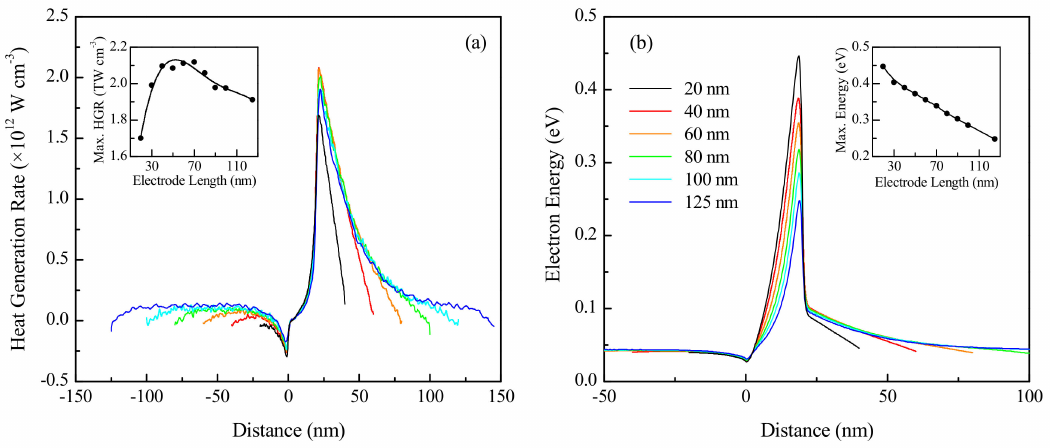
Figure 7. E ff ect of electrode length on the ( a ) heat generation rate and ( b ) electron energy over the length of a 20 nm channel device at 300 K (legends